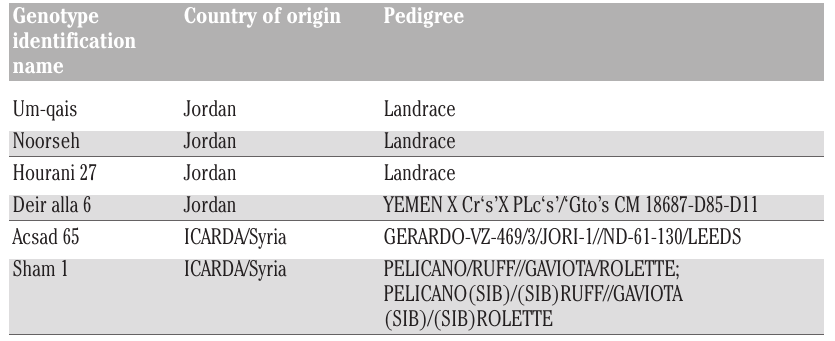
Table 1. Name, origin and pedigree of studied wheat